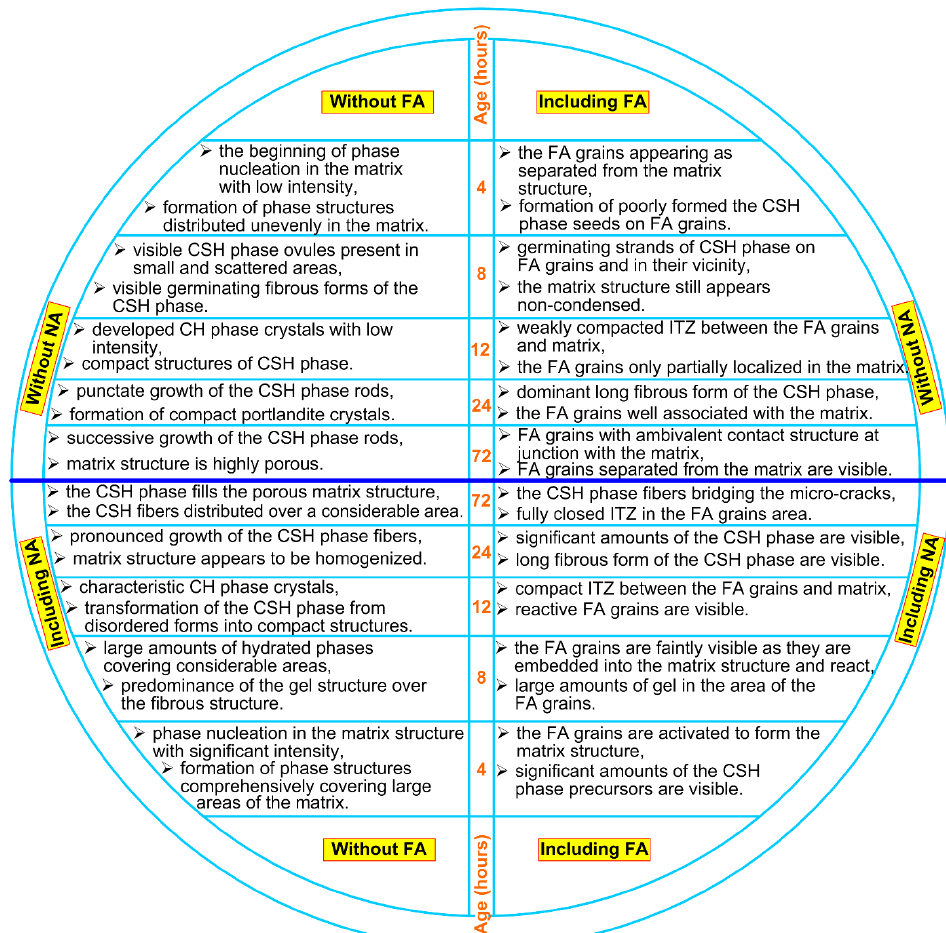
Figure 7. C/S ratio for analyzed samples: ( a ) without FA—relationship between 0FA4NA and 0FA0NA, ( b ) including FA—relationship between 20FA4NA and 20FA0NA. Materials 2021 , 14 , x FOR PEER REVIEW